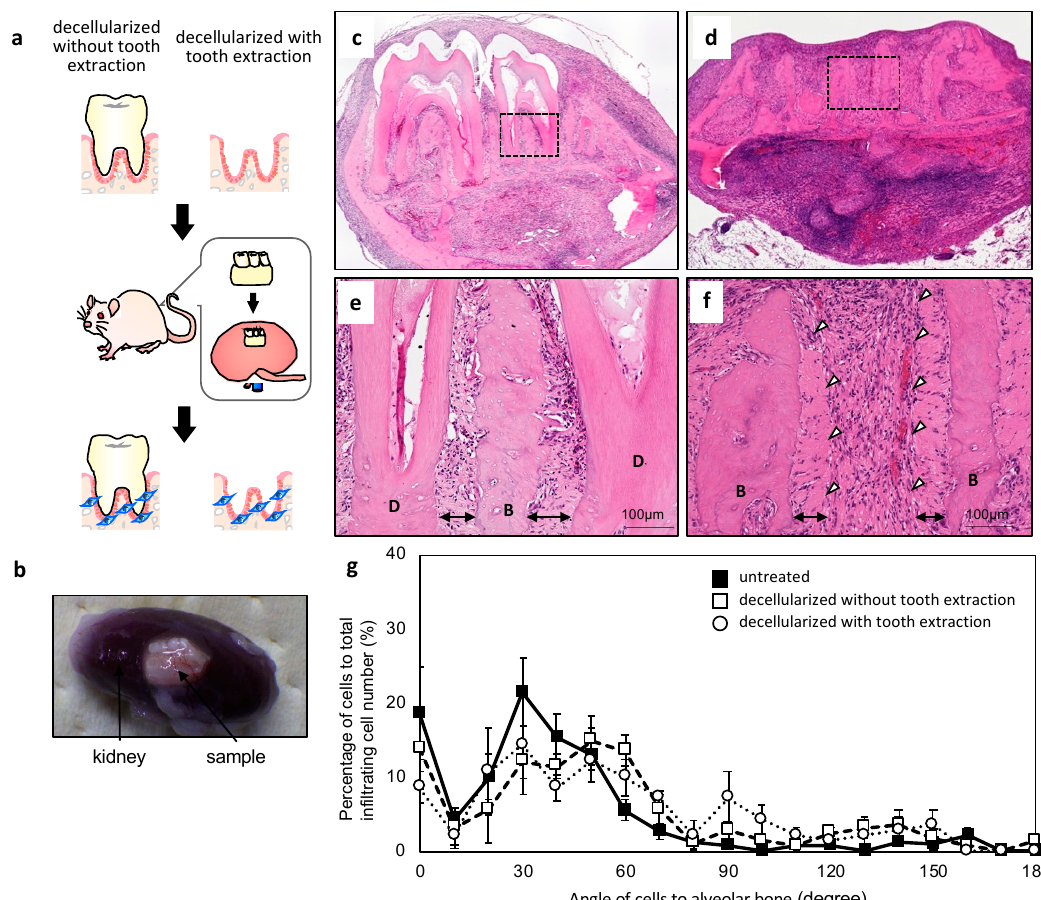
Figure 3. Implantation of decellularized mandible bone without and with tooth extraction. ( a ) Schematic illustration of the implantation process. ( b ) Implanted sample three weeks after the subrenal capsule assay. ( c – f ) HE-stained images of subrenal implantation of decellularized mandible bone without ( c , e ) and with ( d , f ) tooth extraction. Arrows indicate the PDL matrix area. White arrowheads show the surface of the PDL matrix. B, alveolar bone; D, dentin. ( g ) Angle of cells infiltrated into the PDL matrix relative to alveolar bone ( n = 5). * p < 0.05.